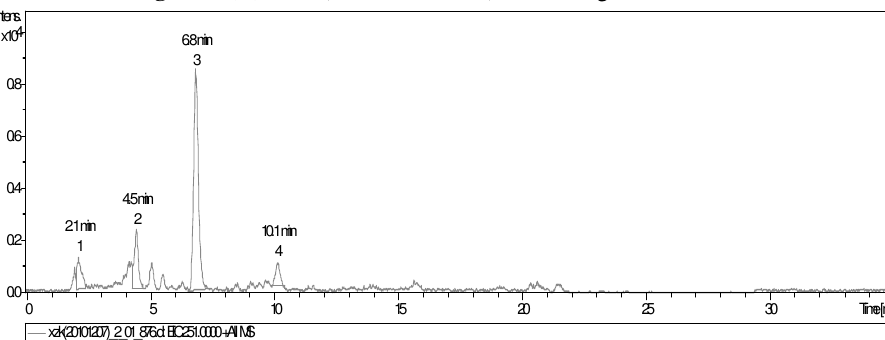
Figure 4 (A). EIC ( m/z 251[M+H] + ) chromatogram of citrinin